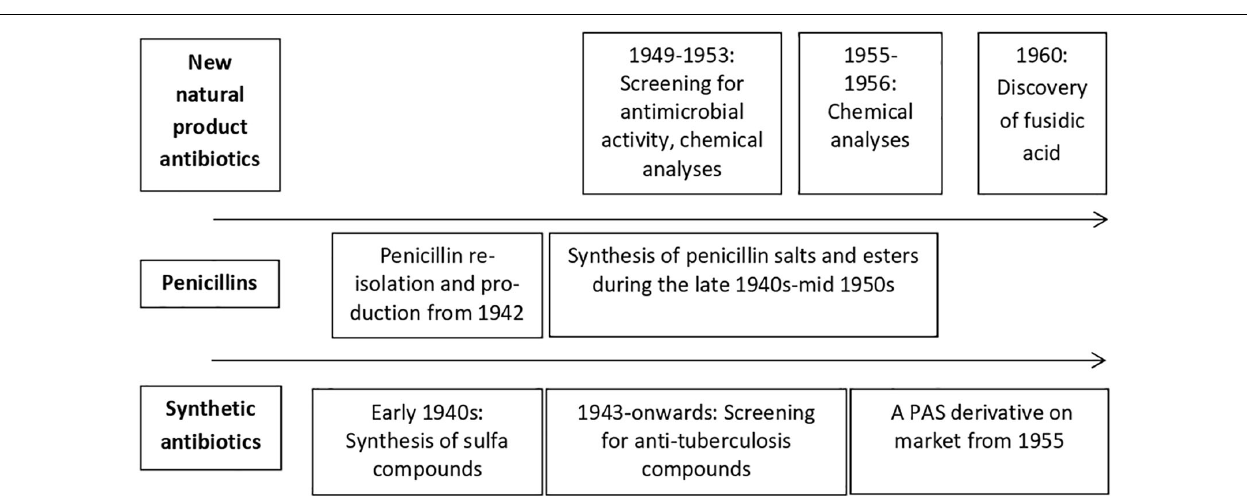
FIGURE 3 | Timeline for the major activities within the antibiotic screening programs at LEO